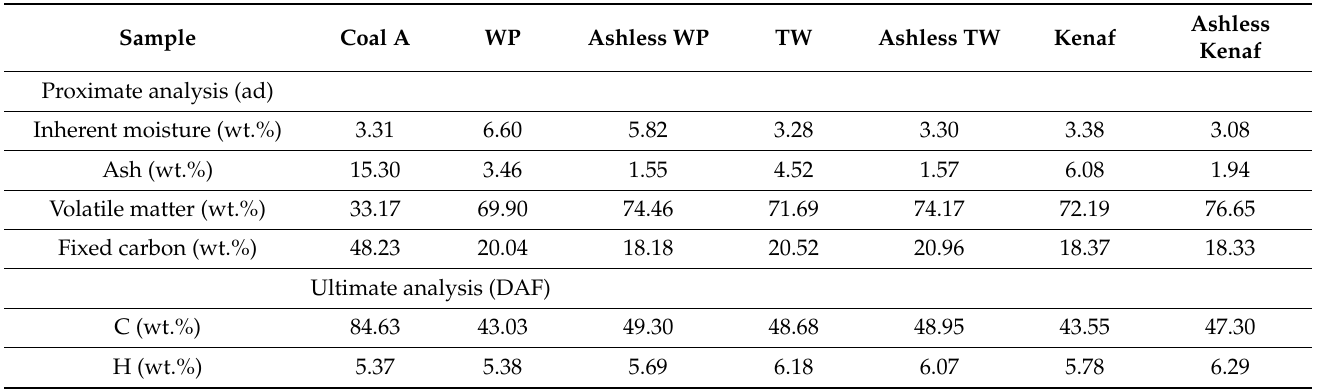
Table 1. Basic properties (proximate, ultimate value and heating value) of coal and biomass samples.